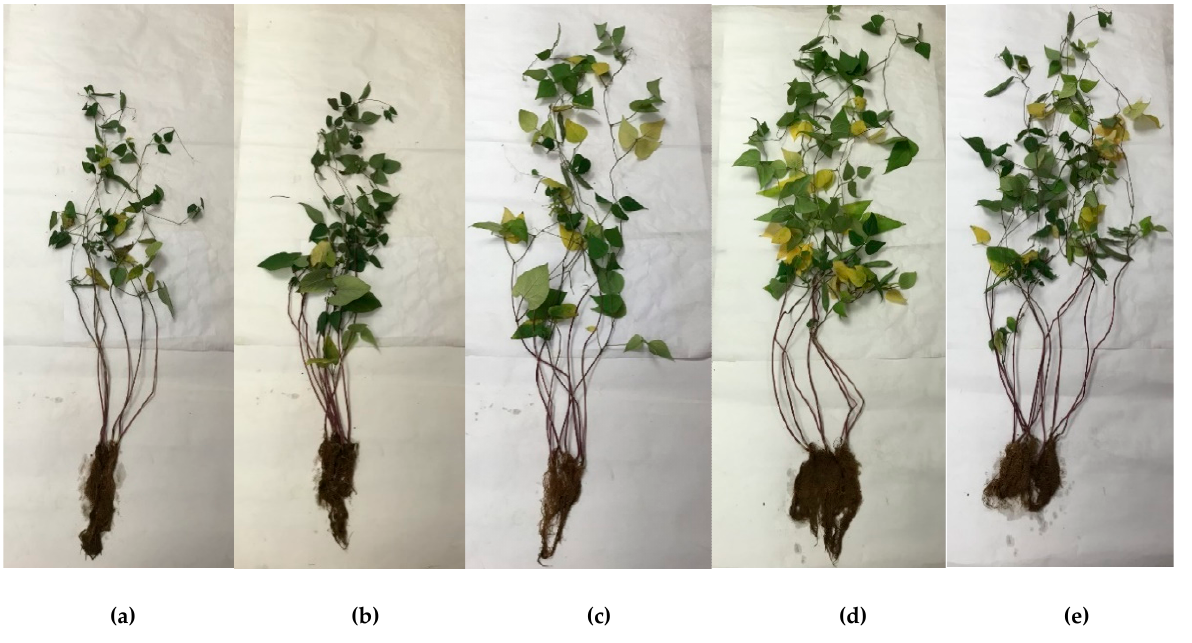
Figure 1. Growth of Phaseolus vulgaris enhanced with Xanthobacter autotrophicus at physiological ma- turity during phytoremediation of agricultural soil impacted by waste motor oil. ( a ) Absolute control P. vulgaris irrigated with water in agricultural soil devoid of waste motor oil (WMO) contamination. ( b ) Relative control P. vulgaris in agricultural soil devoid of WMO contamination, fed by 100% mineral solution (MISO). ( c ) T1 P. vulgaris in agricultural soil impacted by WMO biostimulated with Tween ® 80/ Triton ® X-100 and 50% MISO. ( d ) T2 P. vulgaris in agricultural soil impacted by WMO bios- timulated with Tween ® 80/ Triton ® X-100 and 50% MISO and bioaugmented with X. autotrophicus. ( e ) T3 P. vulgaris enhanced with X. autotrophicus in agricultural soil impacted by WMO biostimulated with Tween ® 80/ Triton ® X-100, 50% MISO and bioaugmented with X. autotrophicus.